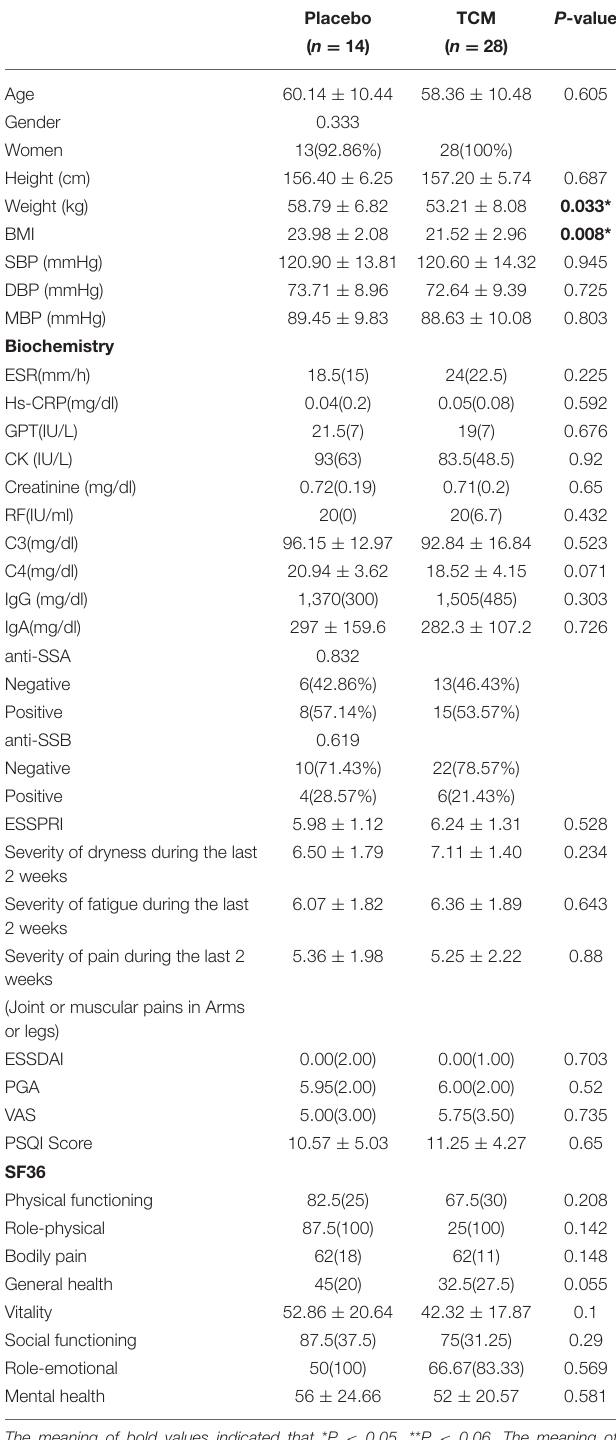
TABLE 1 | Baseline characteristics of the study